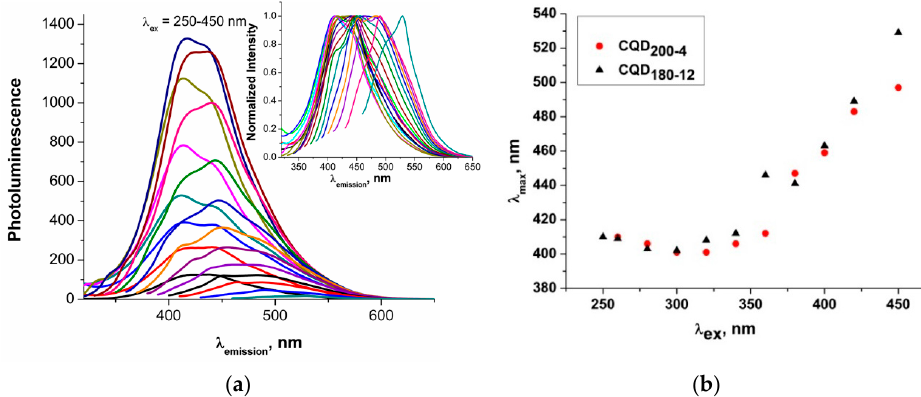
Figure 4. ( a ) PL spectra of the CQD 200-4 aqueous solution excited in a range of λ ex = 250–450 nm; ( b ) the maximum of the wavelength PL emission ( λ max ) as a function of the excitation wavelength ( λ ex